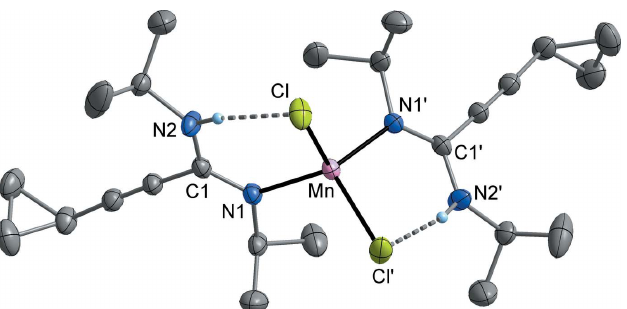
Figure 2 Molecular structure of 3 in the crystal. Displacement ellipsoids are drawn